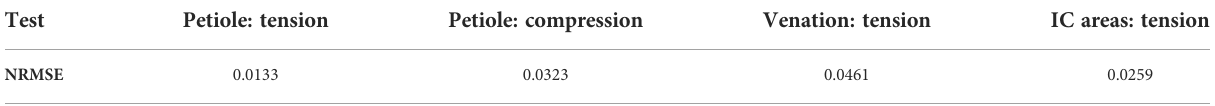
TABLE 3 Normalized root-mean-square errors comparing the simulation and experimental data for cyclic uniaxial stress-relaxation tests. Test Petiole: tension Petiole: compression Venation: tension IC areas: tension